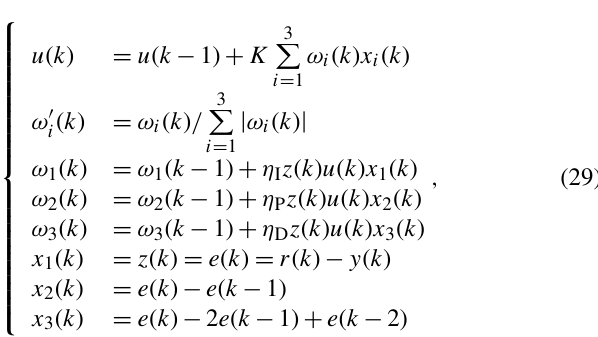
applied to realize the full closed-loop control as shown in Fig. 8. Single neuron self-tuning PID control takes the ideal pose ( R in ) as an input and the actual pose as a feedback to achieve the stability of the grating tiling mechanism of the whole closed-loop